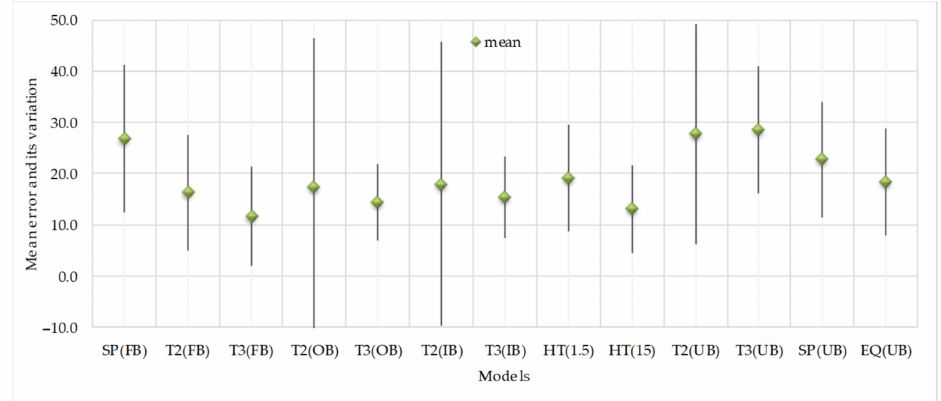
Figure 3. Mean error and their variation for collapse strength models against test data.